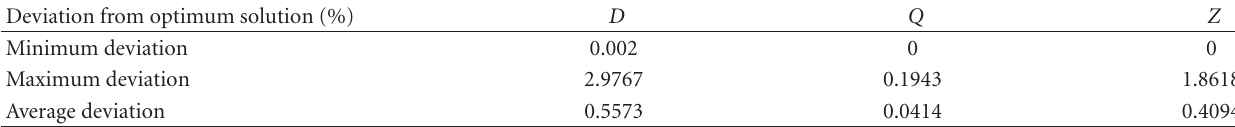
Table 2: Results of comparison between the developed PRB outputs and the optimum